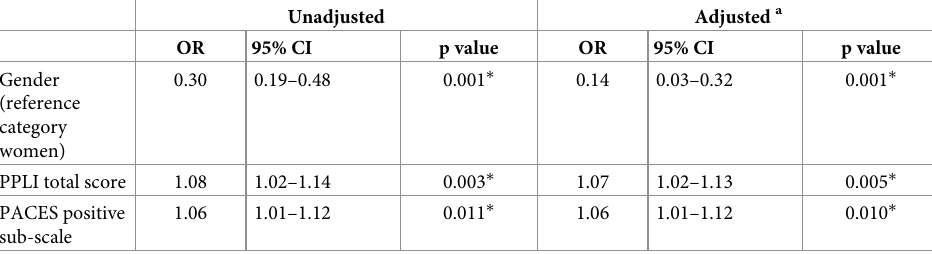
Table 5. Logistic regression analysis for highly active relative to moderately active